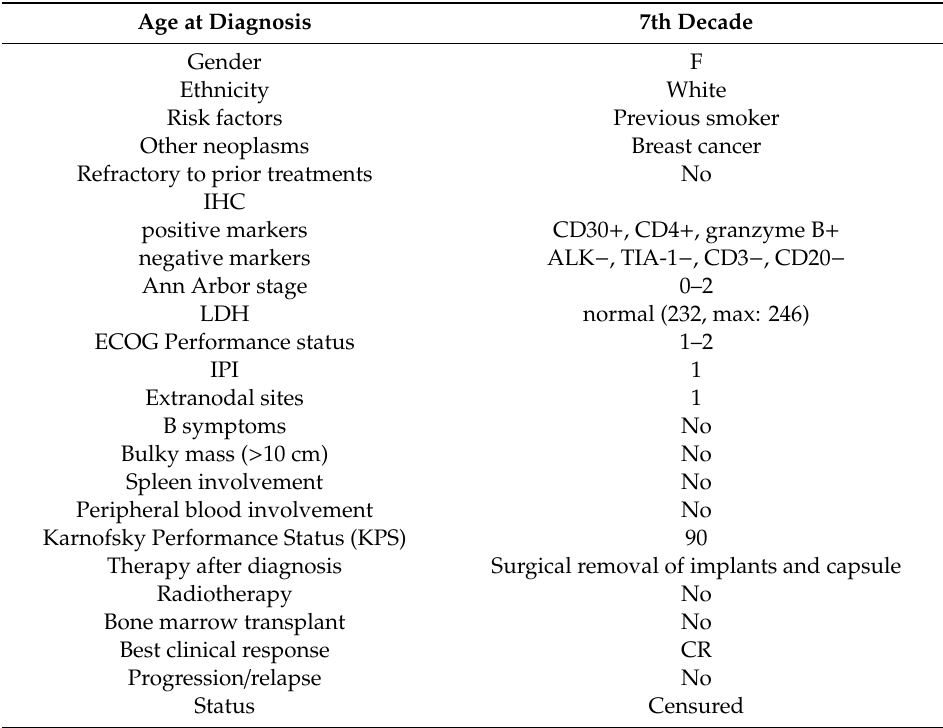
Table 1. Patient’s clinical